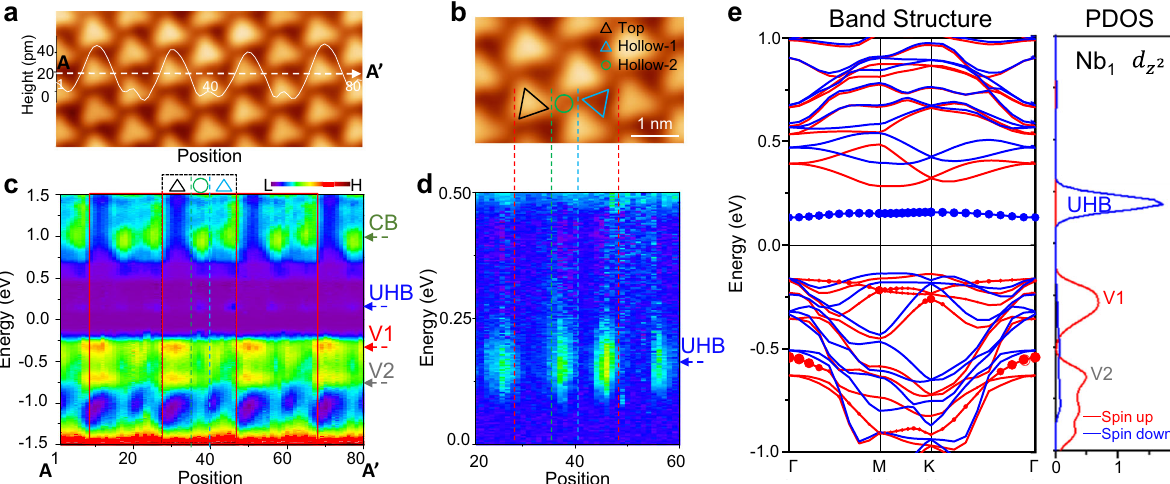
Fig. 2 Spatial-dependent electronic structures of monolayer 1T-NbSe 2 on BLG/SiC(0001). a Area of 1T-NbSe 2 ; AA ′ is the line along which line d I /d V in c is obtained. Line pro fi le (white curve) of AA ′ is shown above AA ′ . b Zoomed-in image of one CDW unit cell showing Top, Hollow-1, and Hollow-2 sites, labeled by black triangle, blue triangle, and green circle, respectively. c Line d I /d V spectra along AA ′ shown in color map mode. Spectra in one unit cell is shown in the frame, which contains Top, Hollow-1, and Hollow-2 regions. Four orbitals are labeled as CB, UHB, V1, and V2. d Zoomed-in image of c in 0 – 0.5 eV range showing spatial dependence of UHB. e Left: calculated band structure of 1T-NbSe 2 , where blue and red dots represent band projections of spin-down and spin-up dz 2 orbitals of the center Nb atom (i.e., Nb 1 ) in SOD, respectively. Right: corresponding partial density of states (PDOS) of Nb 1 dz 2 orbital. Calculations include spin polarization and GGA + U approximation. Scanning and spectroscopy parameters: a and b − 1.5 V, 10 pA; c and d − 1.5 V, 1 nA before turning off feedback loop.